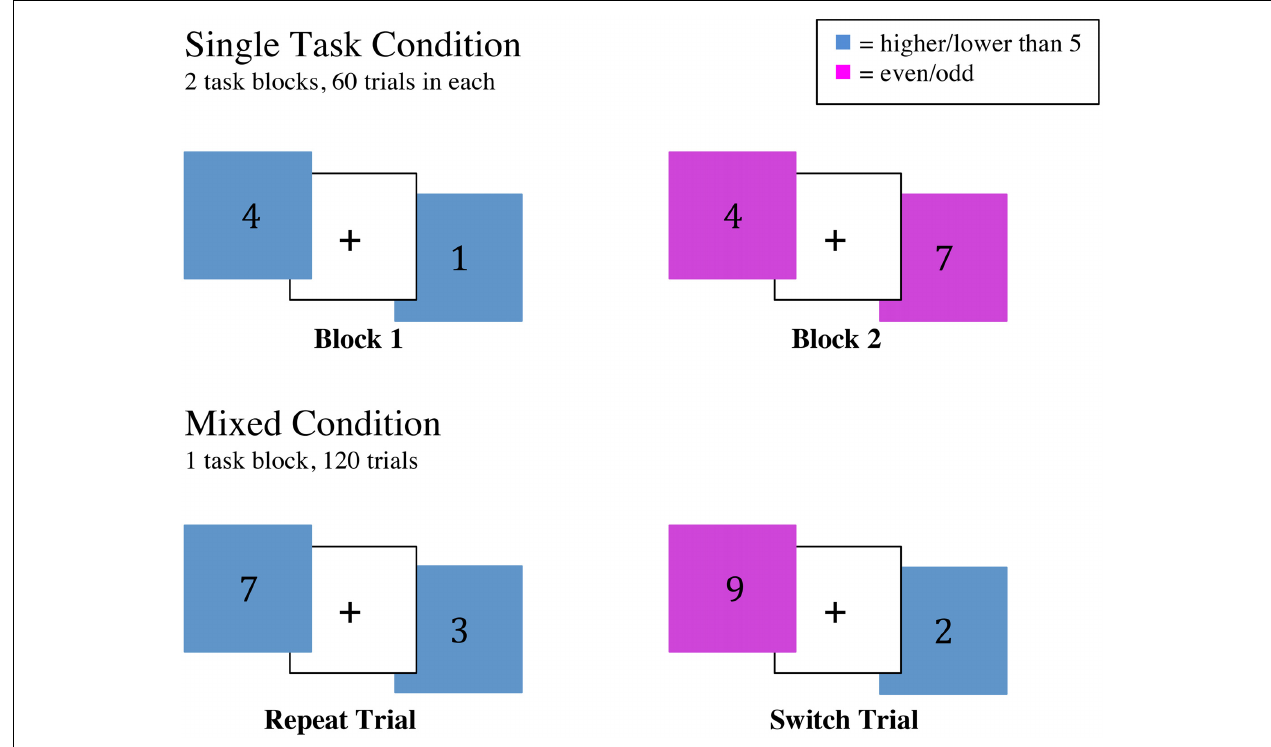
FIGURE 1 | Display of the task-switch paradigm. Participants were instructed to respond to a number between 1 and 9 (except for 5) that appeared centrally located on the computer screen. The background color (blue/pink) cued them as to the task they would